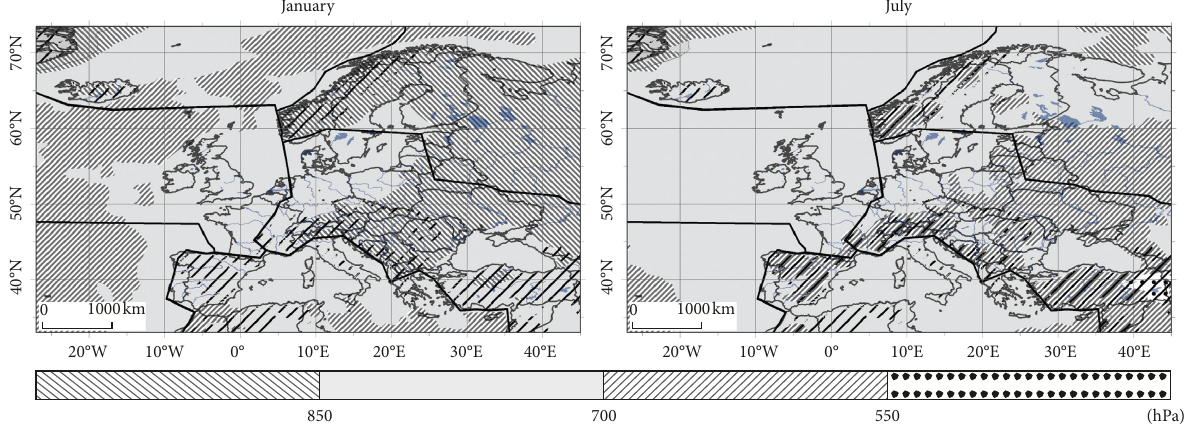
Figure 6: Mean height (hPa) of humidity inversion base (1981–2015); slanted lines are used to denote areas situated above the average 950hPa